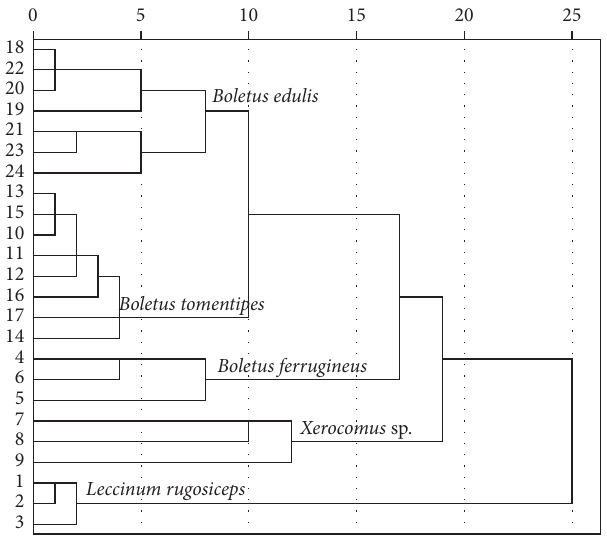
Figure 6: Dendrogram resulting from hierarchical cluster